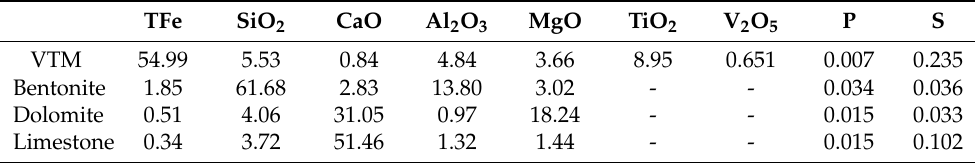
Table 1. Chemical composition of raw materials/wt %.